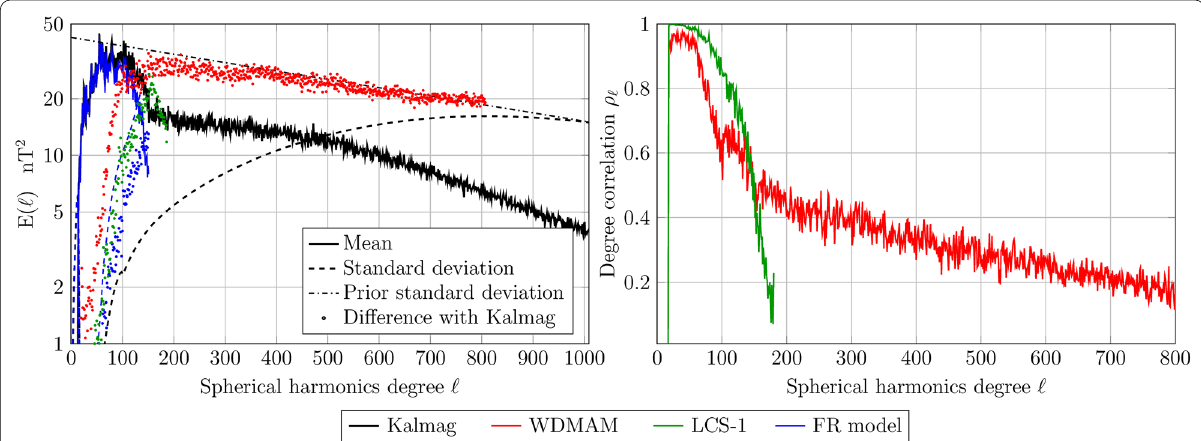
Fig. 7 Left: energy spectra at the Earth’s surface of the mean (continuous lines), the standard deviations (dashed lines), and the prior standard deviation (dash dotted line) for the Kalmag lithospheric model (black lines) and the FR model (blue lines). Dots represent the spectra of the difference between the Kalmag model and the WDMAM model by Lesur et al. (2016) (red), the LCS‑1 model by Olsen et al. (2017) (green), and the FR model (blue). Right: degree correlation ρ ℓ between the Kalmag lithospheric field model and the WDMAM model (red lines), and the LCS‑1 model (green